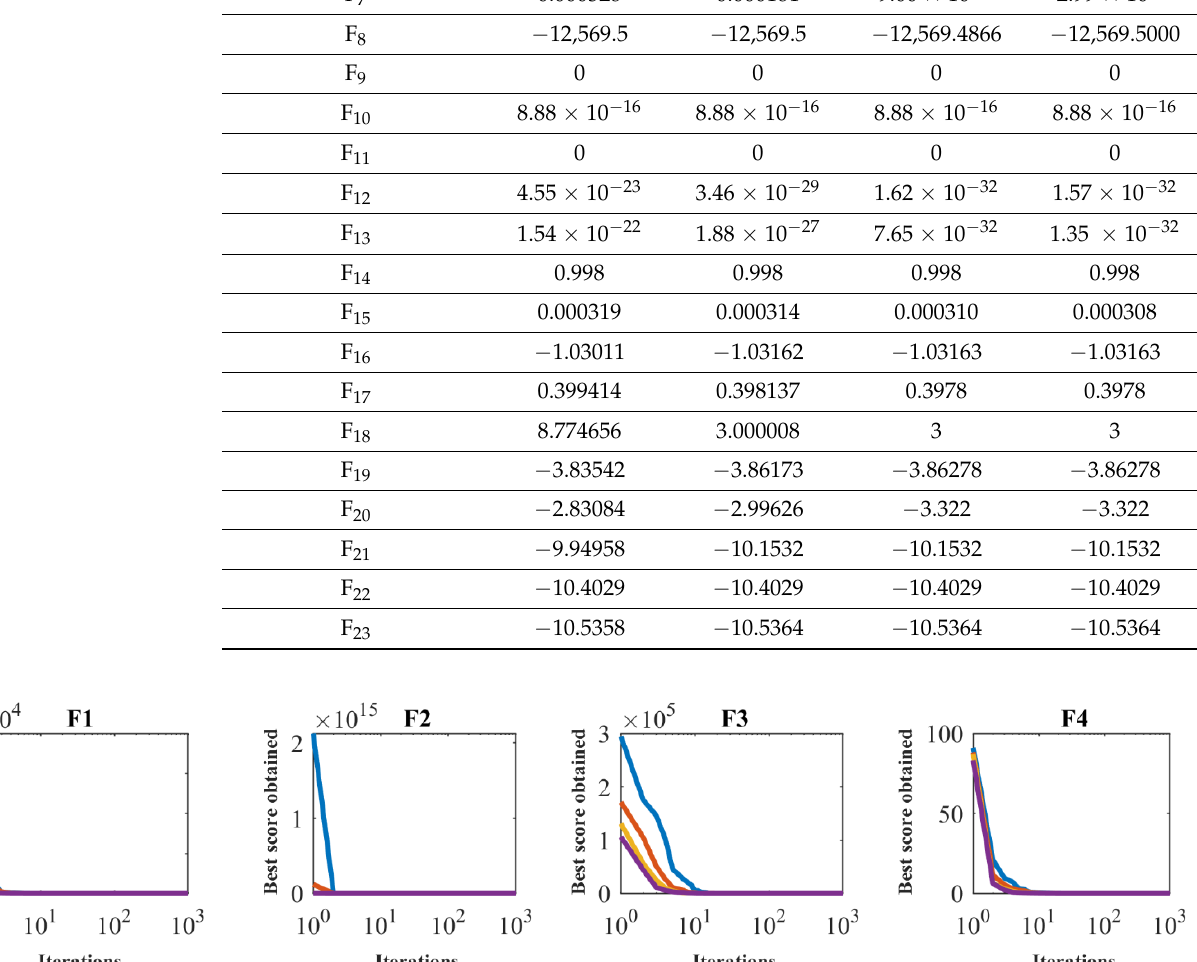
Table 6. Results of sensitivity analysis of SSVUBA to N .